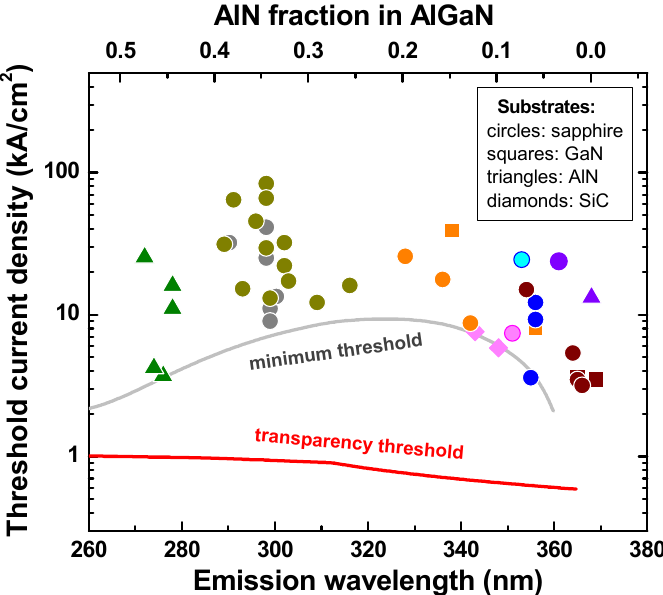
Figure 1. Experimental threshold current densities of UV laser diodes fabricated on various sub- strates (symbols) vs. oscillation wavelength [24–26]. The grey line is an approximation for the min- imum threshold current density drawn as a guide to the eye. The red line is the calculated transpar- ency threshold (see text for more detail). The top scale displays the compositions of bulk AlGaN corresponding to the wavelengths indicated in the bottom scale.